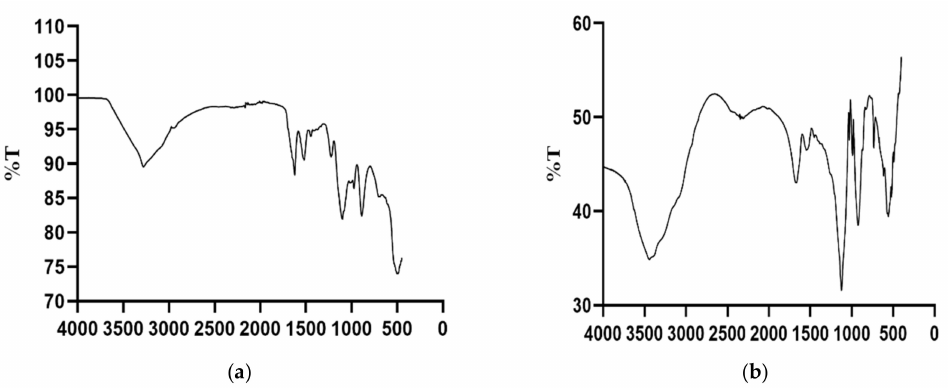
Figure 4. ( a ) FTIR spectrum of silk fibroin protein (SF) microparticles; ( b ) FTIR spectrum of SFCP microparticles. X-axis corresponding to λ (cm − 1